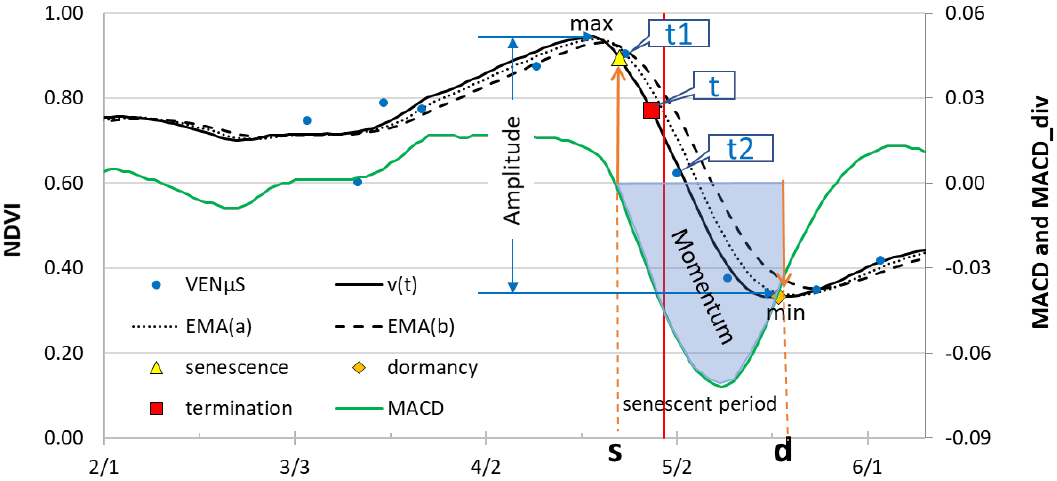
Figure 4. An example diagram of NDVI and MACD shows the senescence onset (“s”), dormancy (“d”), and the termination date (“t”) of a winter cover crop (triticale and ryegrass mixture) detected from the NDVI and MACD time-series. The WIST algorithm detected a termination date of 28 April 2019 (red square) and the actual termination date was on 30 April 2019 (vertical red line). Dates t1 and t2 represent the period with the most rapid-rate of decrease of NDVI (defined in Section 3.1.3).